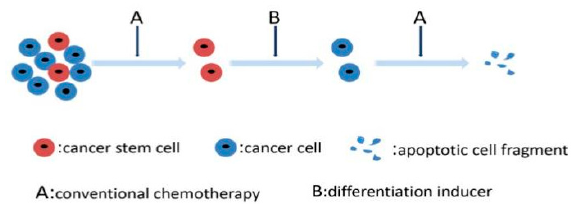
Figure 4. Inducing differentiation therapy to eliminate